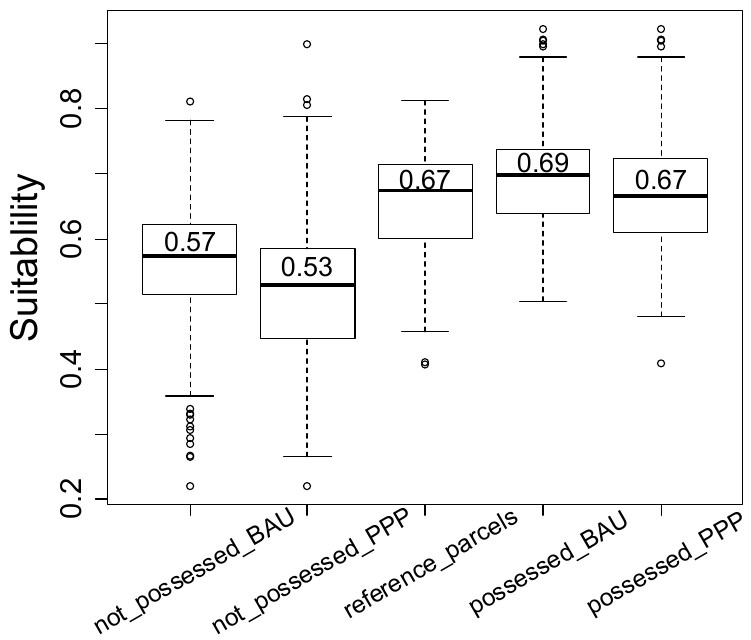
Figure 6. Suitability dispersion of reference-parcels, acquired parcels and not